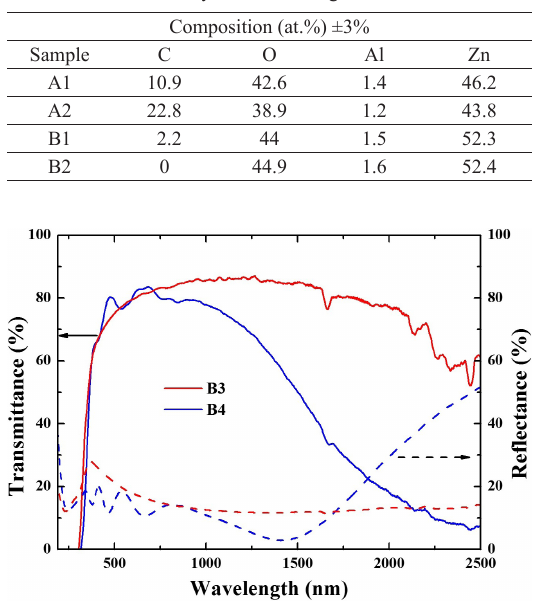
Figure 5. Transmittance and reflectance spectra of AZO/PET films deposited under the conditions of sample B2 (PMS and d for 5 min (B3) and 30 min (B4).